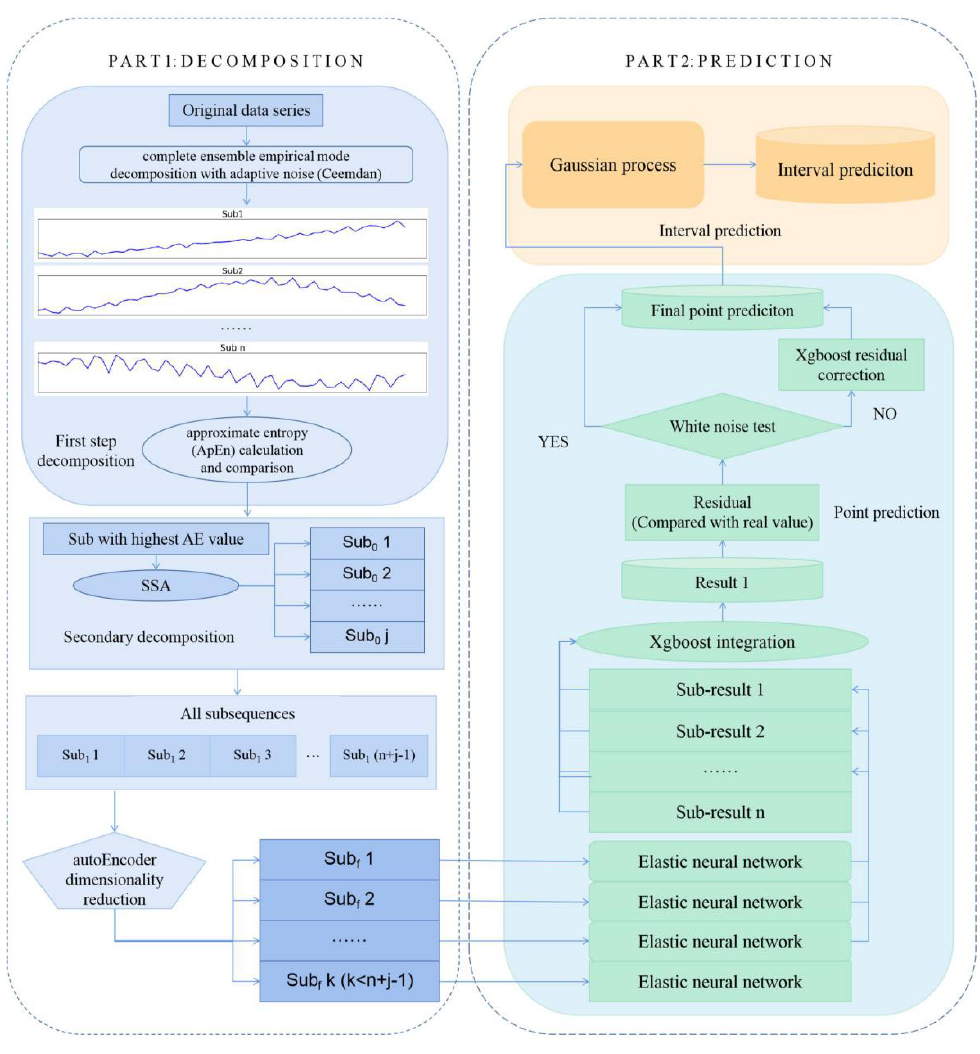
Figure 2. Flowchart of the proposed model.